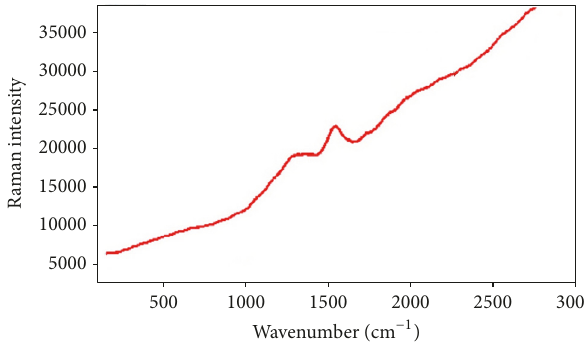
Figure 2: Raman spectrum of the graphene oxide sheets produced by modified Hammers method from graphite